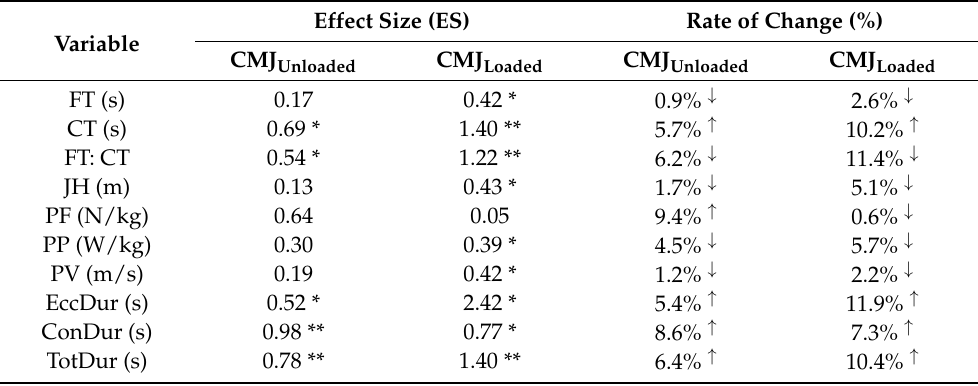
Table 2. Comparison of pre-test and post-24-h effect size and rate of percentage change in counter- movement jump